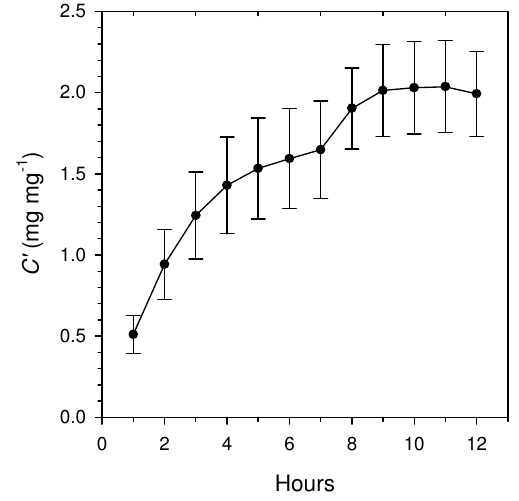
Fig. 3. Means and standard error of stored water in T. recurvata during 12h wetting by simulated fog at ≥ 90%RH and 22 ◦